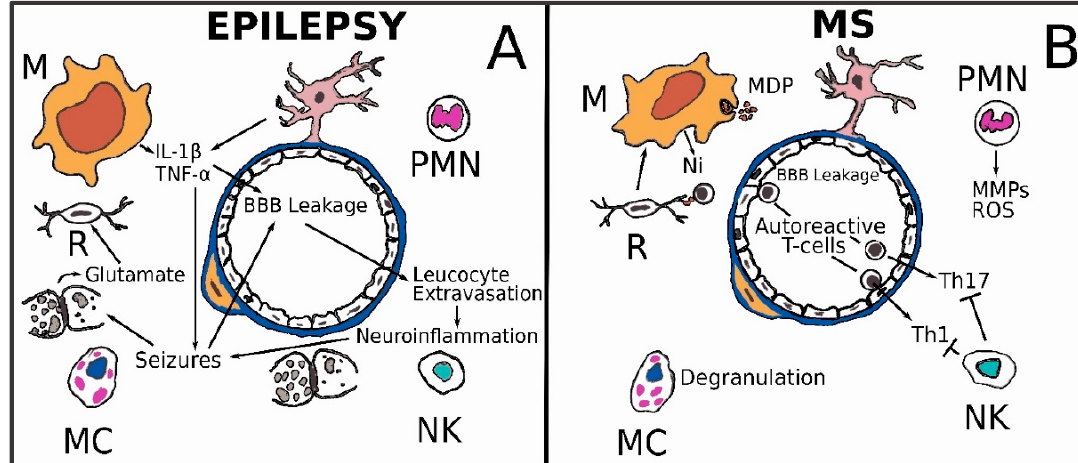
Figure 4. ( A ) A relationship of reciprocal induction may exist between epilepsy and neuroinflammation. Seizures cause BBB leakage that allows inflammatory cells to enter the brain tissue and release excitatory amino acids. Neuroinflammation (Ni), in turn, causes seizures altering neuronal excitability; ( B ) A precocious BBB leakage, both paracellular and transcellular, is present in multiple sclerosis (MS). Autoreactive T cells, among helper subsets T H 1 and T H 17, burst into the nervous tissue and may be activated by myelin debris (MDP) presented from microglial cells or inhibited by NK cells. Macrophages phagocytosis of MDP contribute to the activation state of pro-inflammatory macrophages that produce cytokines. PMNs can increase permeability of the vascular barrier by ROS and MMPs, Microglia activation is a primary feature of MS.